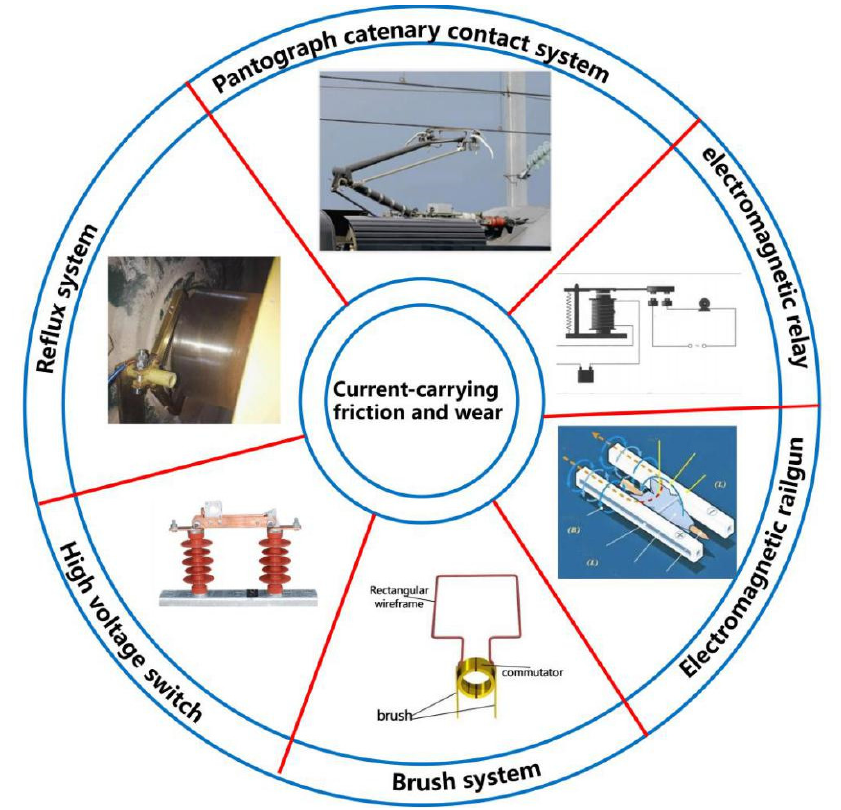
Figure 1. The application of current-carrying friction and wear in different fields.